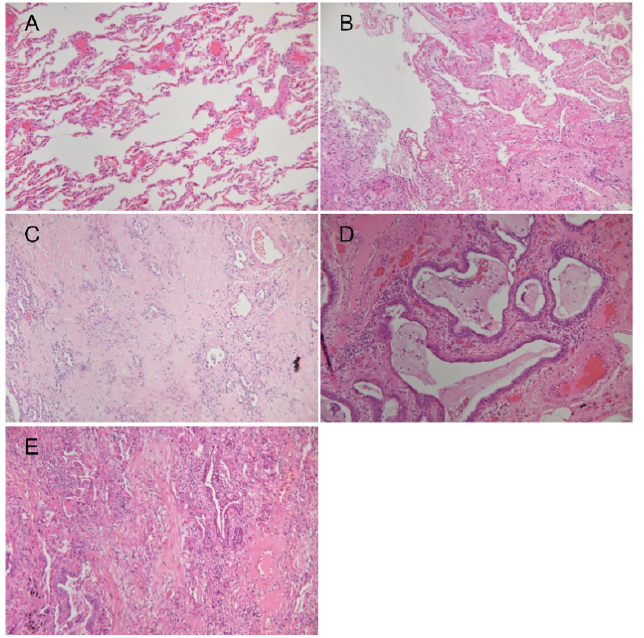
Figure 2. Human lung tissues samples from enrolled patients stained using hematoxylin and eosin. ( A ) Normal lung tissue defined as thin alveolar capillary membrane with clear alveolar space; ( B ) diffuse alveolar damage in which alveolar surfaces are lined with hyaline membranes; ( C ) lung tis- sue showing distinct indications of interstitial fibrosis; ( D ) UIP showing honeycomb fibrosis; ( E ) organizing pneumonia indicating acute exacerbation of UIP. 4X magnification. UIP: usual intersti- tial pneumonia.